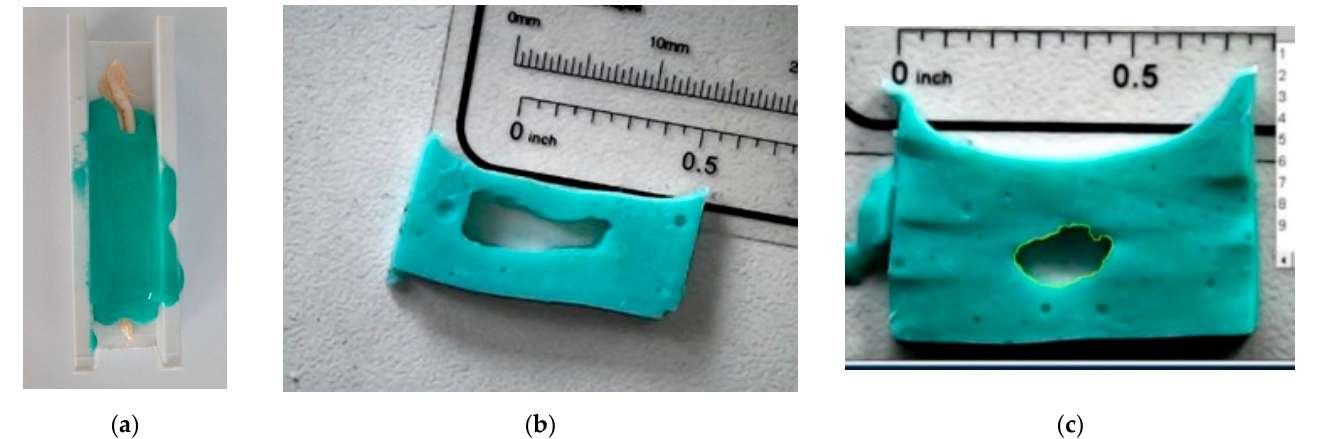
Figure 9. Tendon’s CSA measurement: ( a ) specimen in the mold filled with an alginate paste; ( b ) the CSA and the shape of the quadriceps tendon; ( c ) the CSA and shape of the gracilis tendon with image analysis and measurement. Table 2. The dimensions of the tendons.